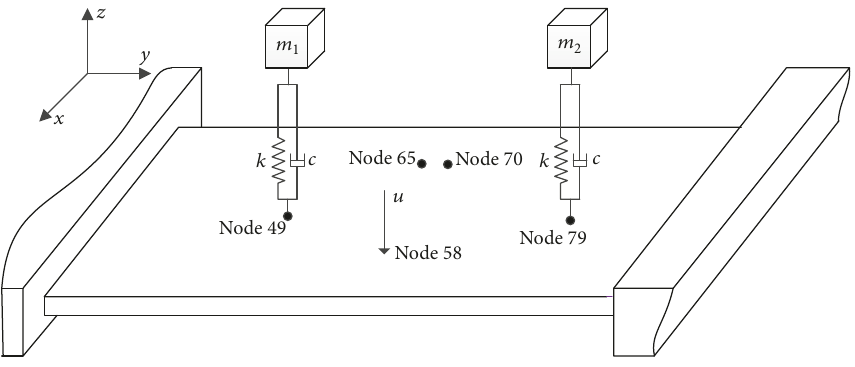
Figure 11: The single-stage isolation system.